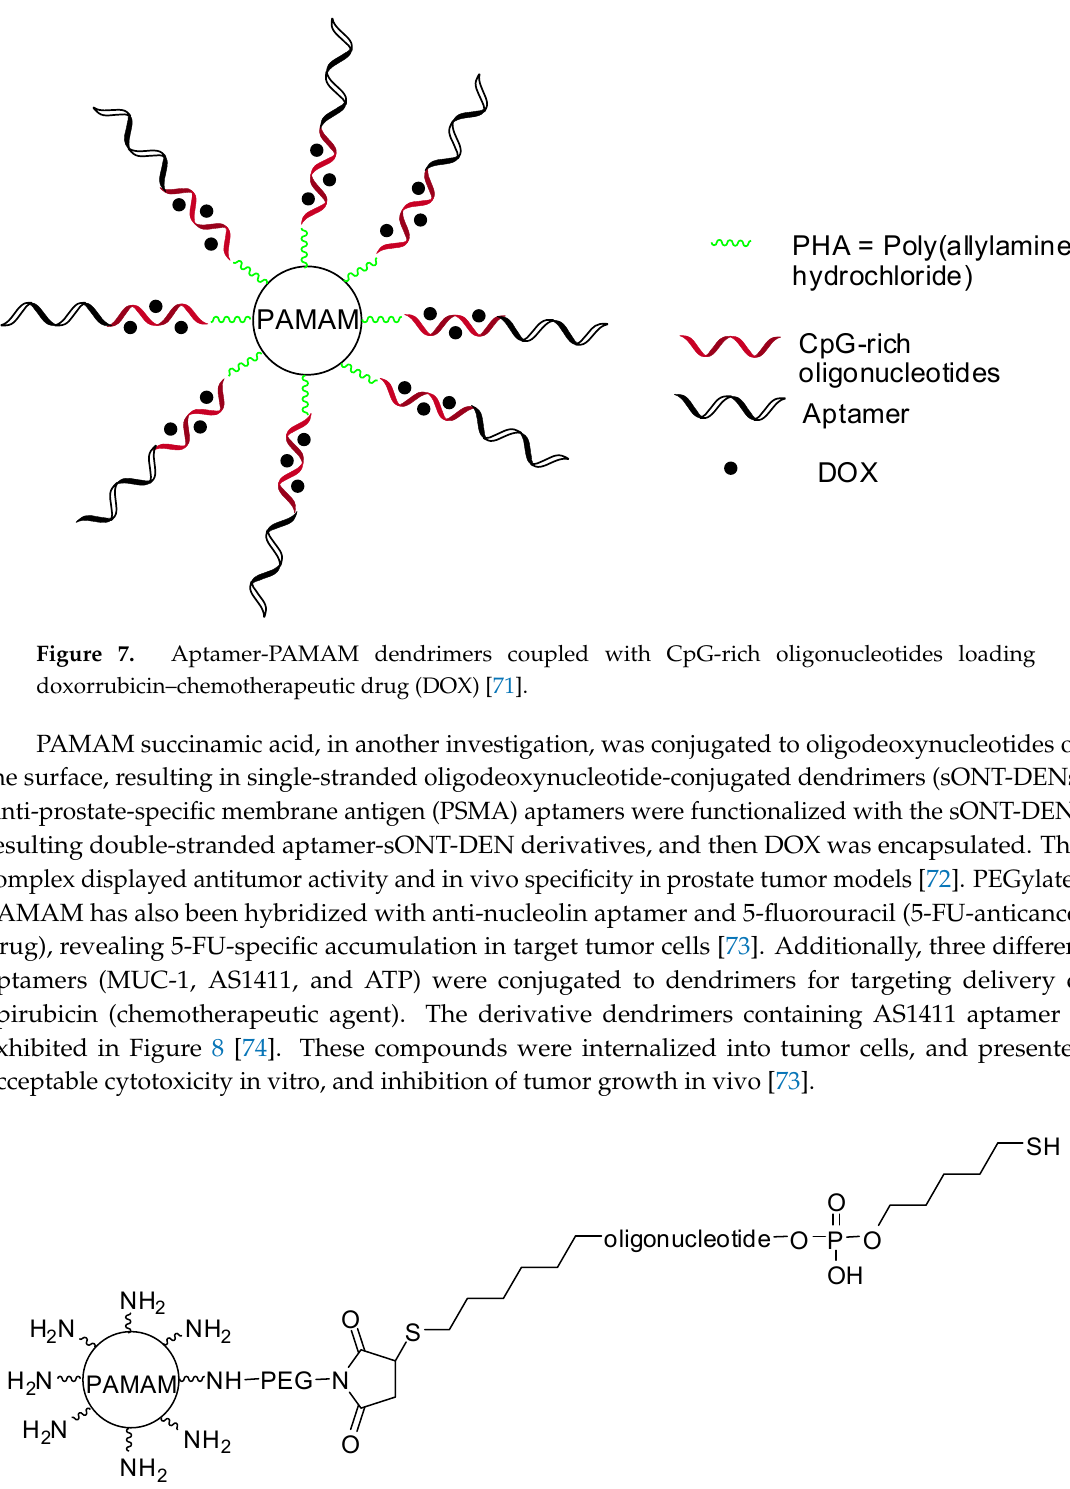
Figure 8. Smart AS1411 aptamer-functionalized/PAMAM dendrimers as nanocarriers for targeting drug delivery for gastric cancer [74].